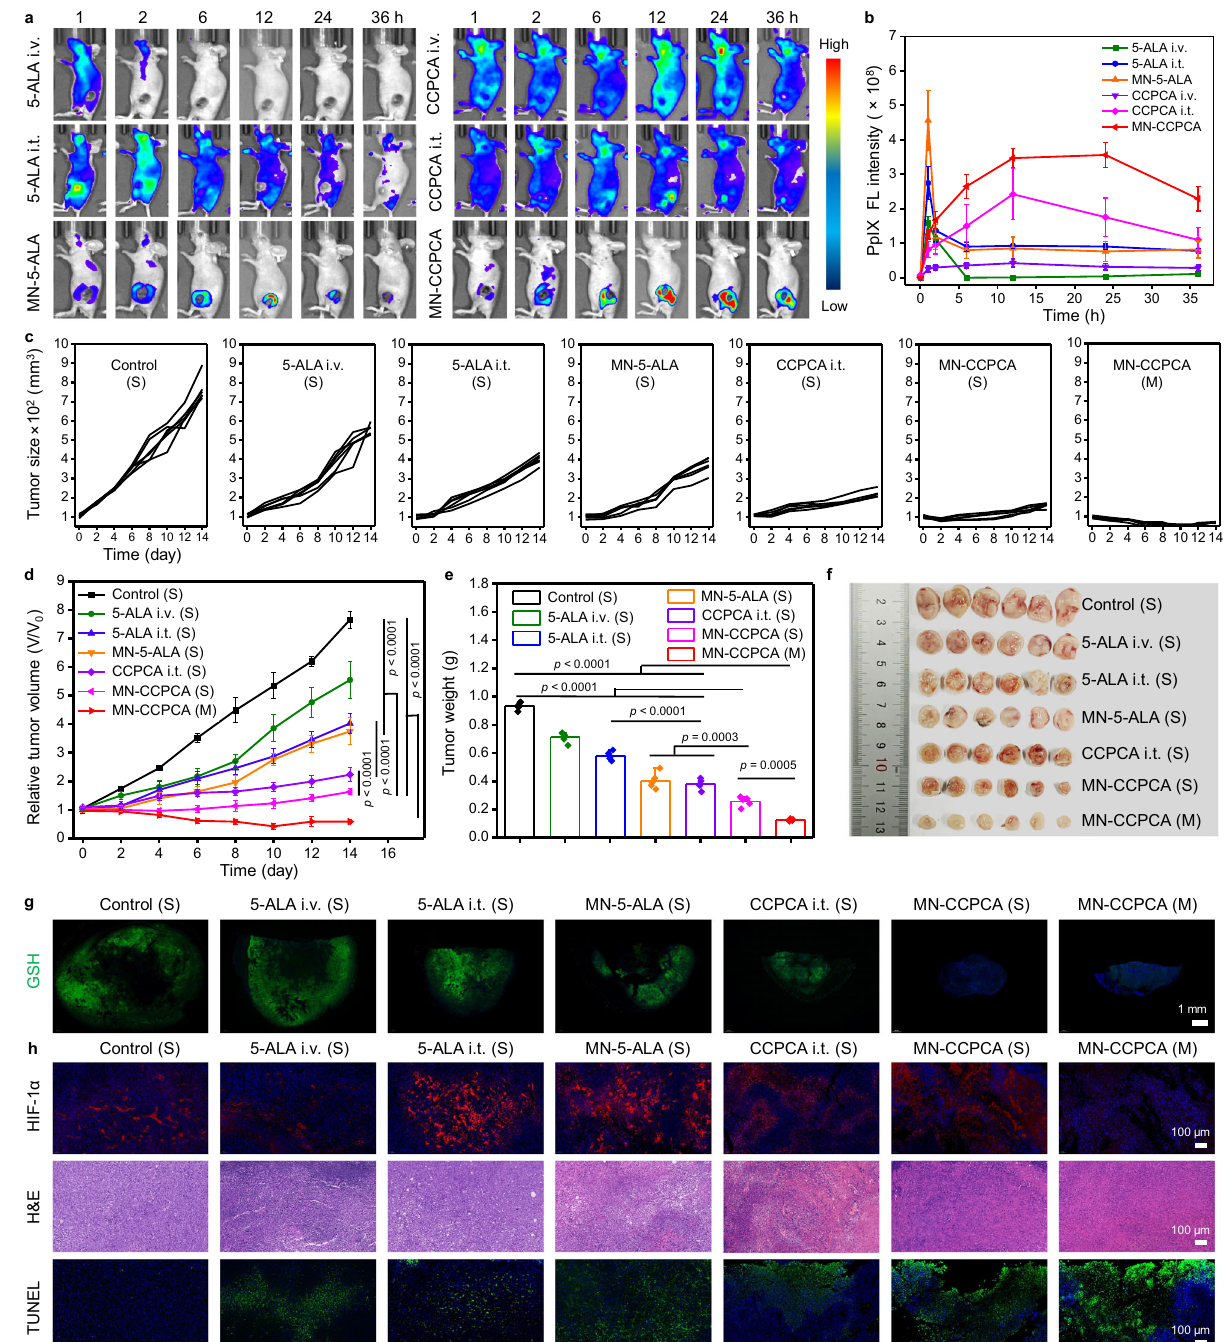
Fig. 7 | Antitumor effects of MN-CCPCA patch in a 4T1 tumor model. a In vivo PpIXFLimagesof4T1tumor-bearingmiceafteradministrationof5-ALAi.v.,5-ALA i.t., MN-5-ALA, CCPCA i.v., CCPCA i.t., and MN-CCPCA patch at the indicated time points. b PpIX FL intensities of tumor tissues after different treatments at the indicated time points. Data represent the means±SD from three biologically independent female 4T1 tumor-bearing mice, n =3. c Individual tumor growth curves, d relativetumorvolumegrowthcurves,and e 4T1tumorweightindifferent treatment groups on day 14, the symbols “ S ” indicate single laser irradiation and “ M ” indicate multiple laser irradiation. Data represent the means±SD from six